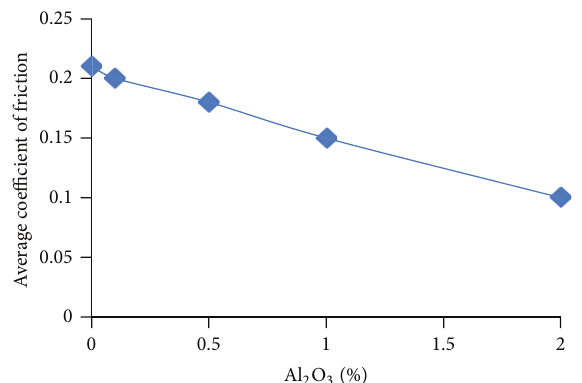
Figure 19: Variation in coefficient of friction of EN-coatings as a function of Al 2 O 3 with surfactant (SLS) in EN bath.